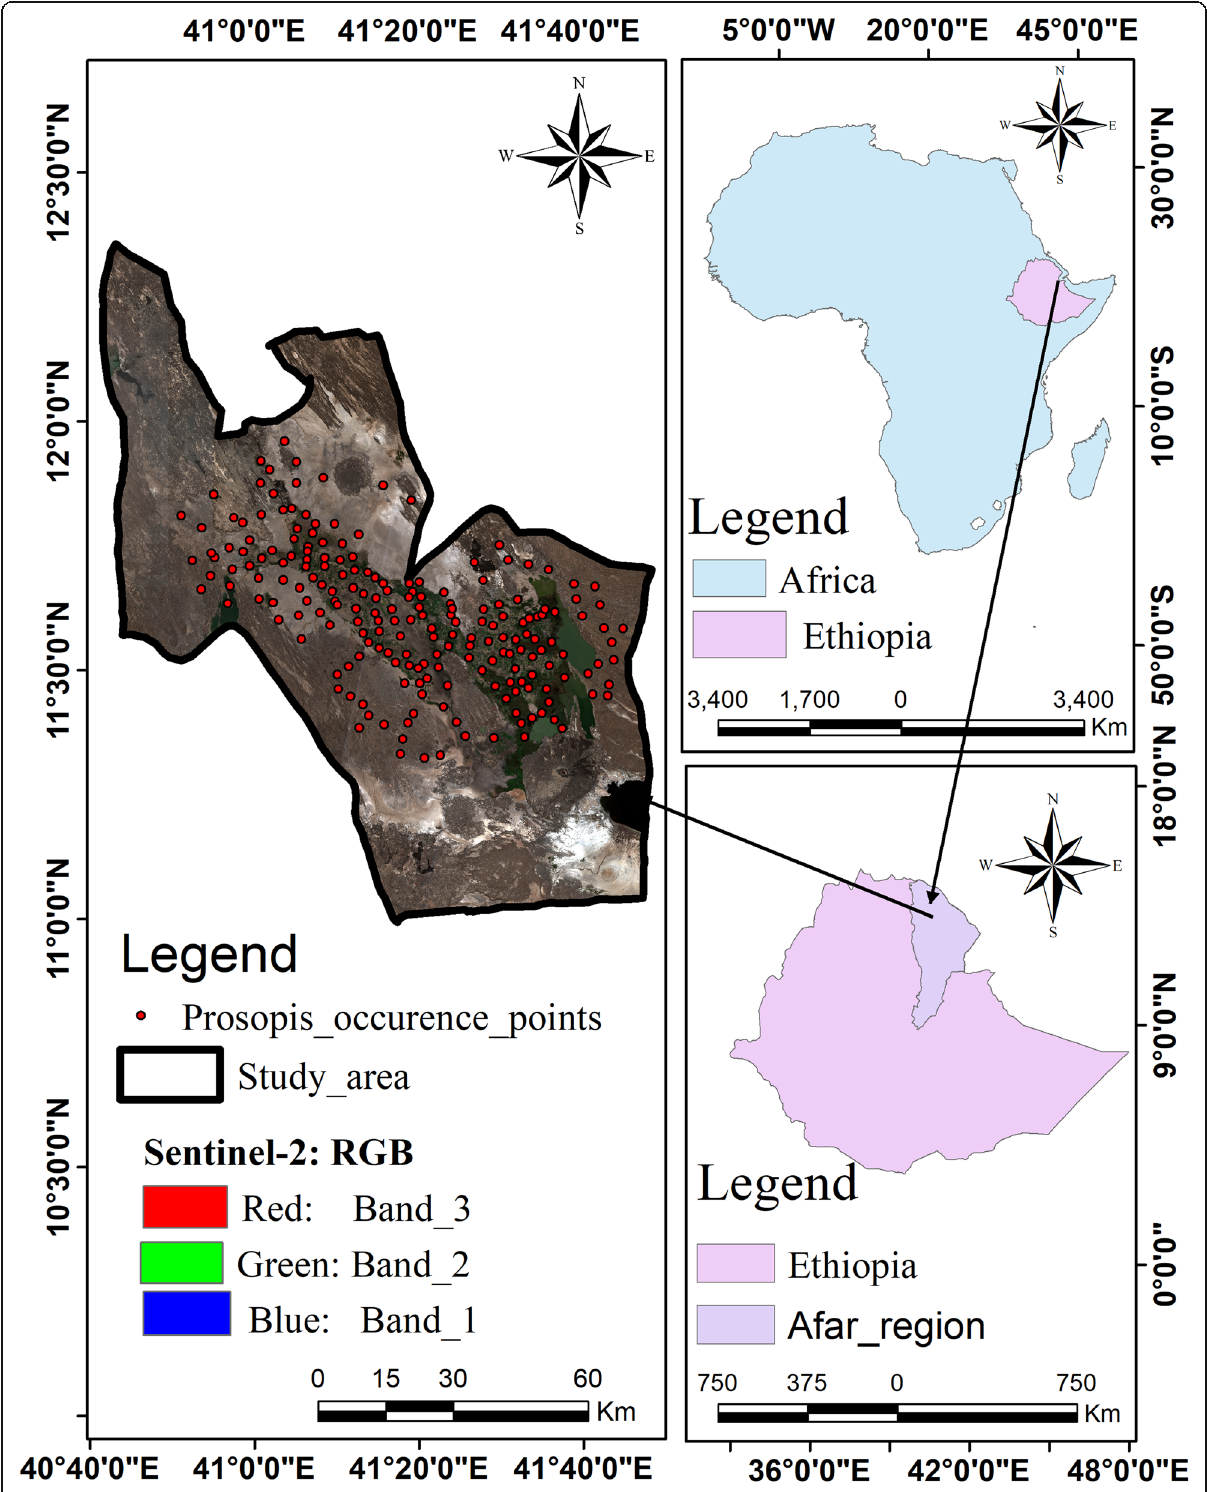
Fig. 1 Location of the study area using Sentinel-2 true-color image composite (left), including in situ collected occurrence points of Prosopis ; map of Africa (upper right) including the location of Ethiopia; and map of Ethiopia (lower right) including the location of Afar regional